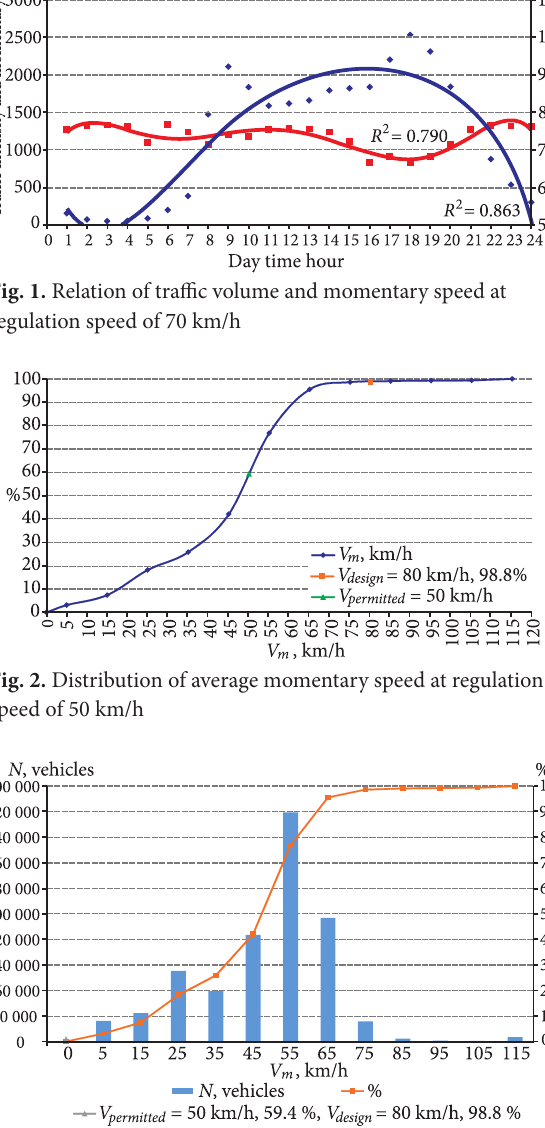
Fig. 3. Histogram of average momentary